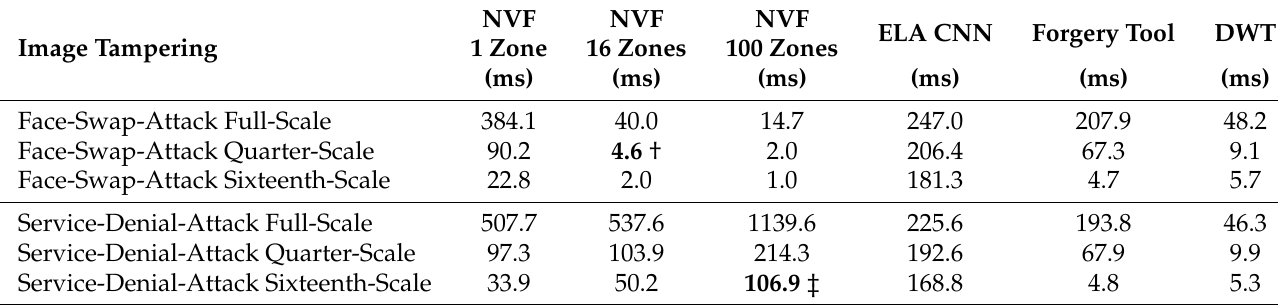
† represents the optimized face-swap detection algorithm: FZV with 16 zones at quarter-scale. ‡ represents the optimized service-denial detection algorithm: ZEV with 100 zones at